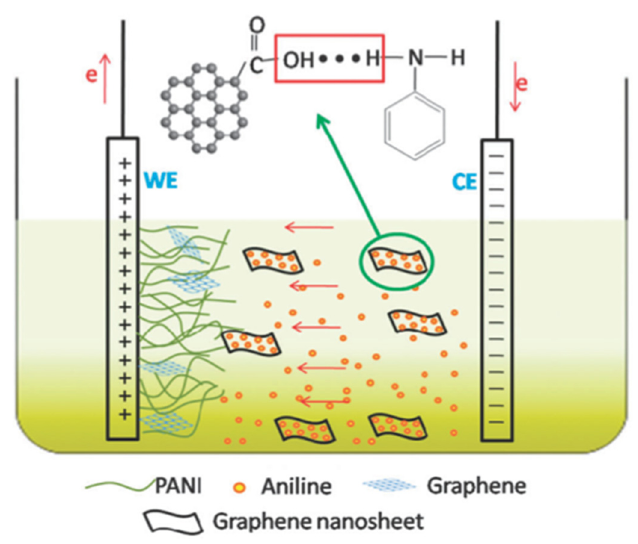
Figure 9. Scheme of in situ polymerization of nanorod-PANI-graphene developed by Hu et al. Reproduced with permission from reference [11] . Copyright (2012) The Royal Society of Chemis- try.